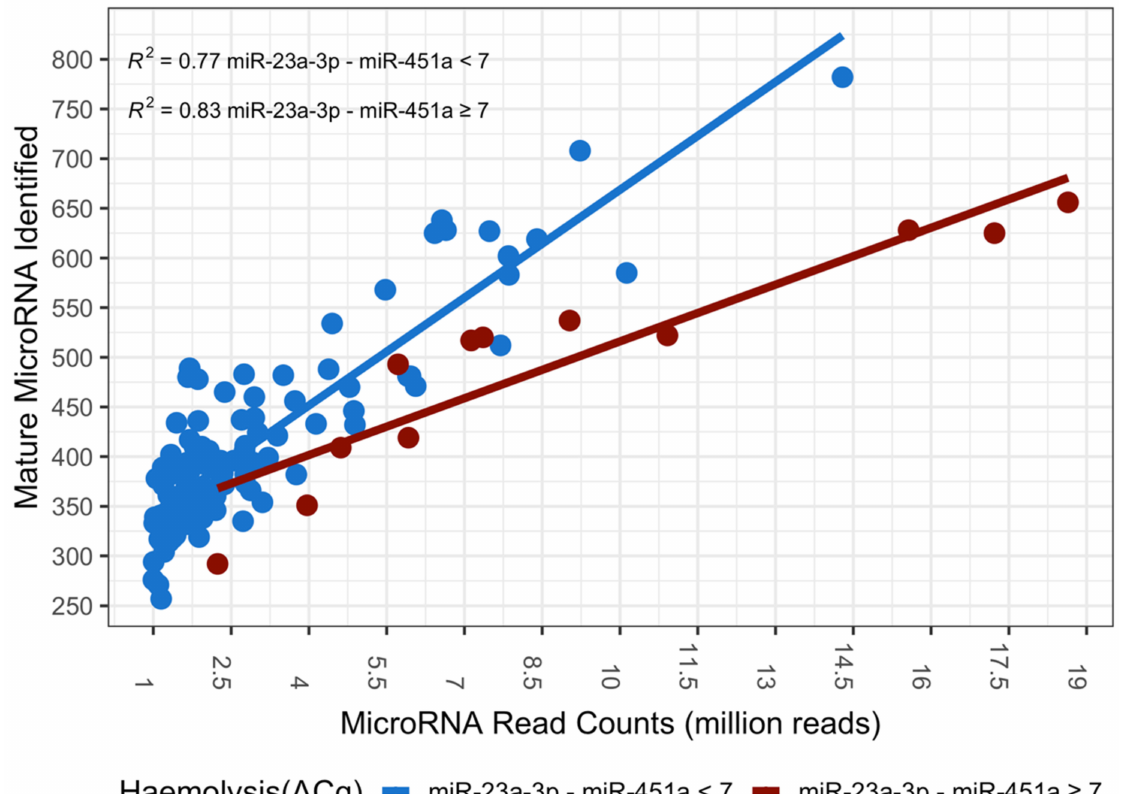
Figure 1. The number of mature miRNA species identified in an individual sample increases with read depth for both haemolysed (dark red) and non-haemolysed (blue) samples. However, the number of mature miRNA species identified for a given read depth is significantly lower (ANOVA, p -value = 1.68 × 10-9) in samples affected by haemolysis when compared to a non-haemolysed sample of equal read depth ( n =